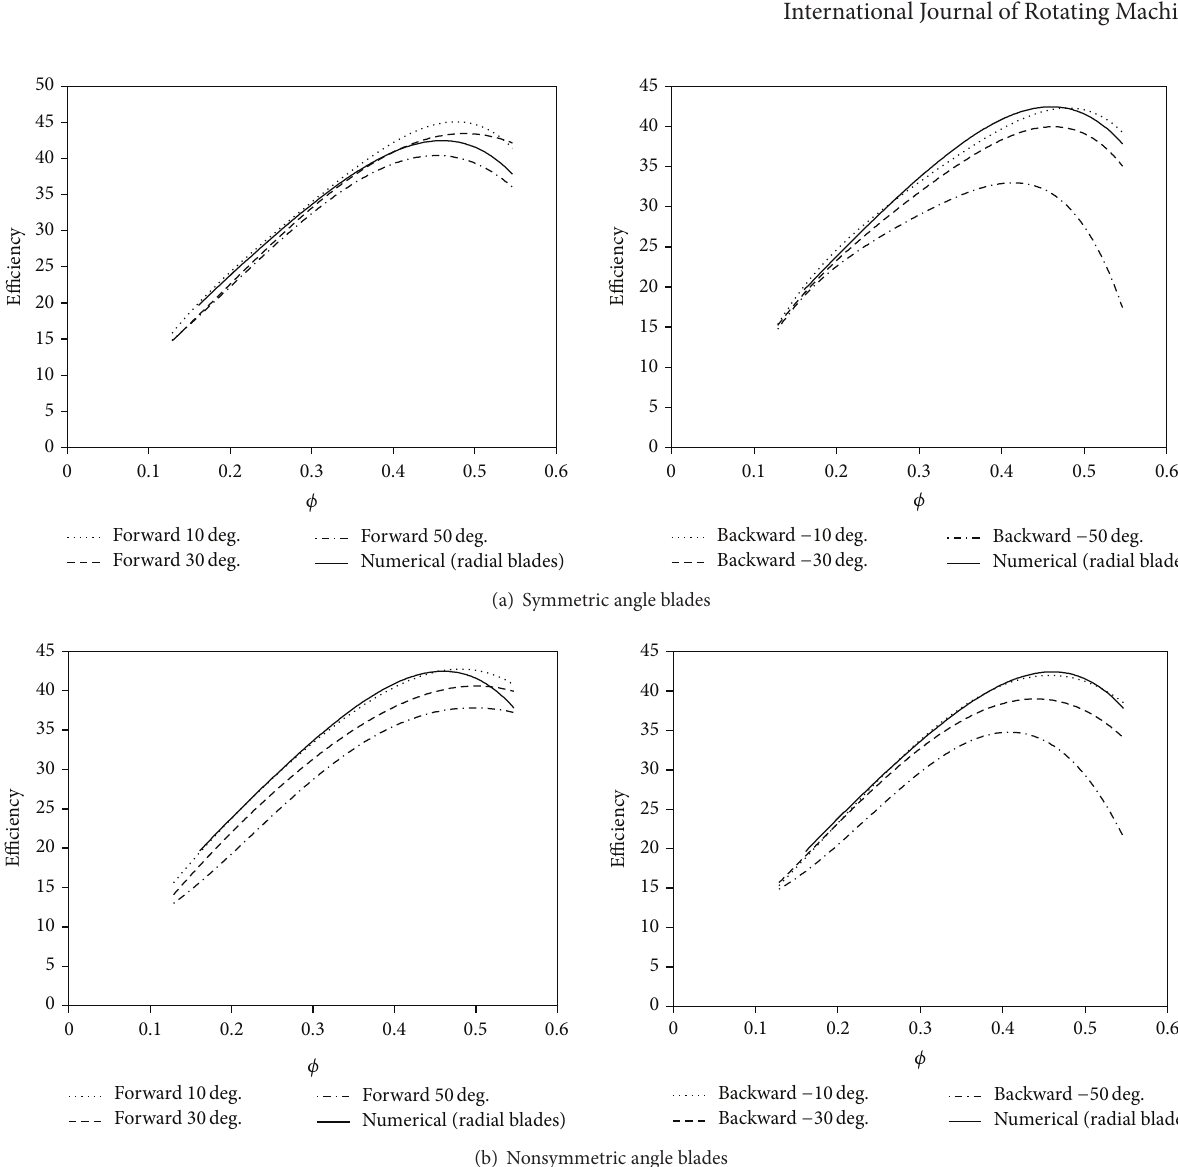
Figure 17: Efficiency curves of the regenerative pump: (a) symmetric blades and (b) nonsymmetric